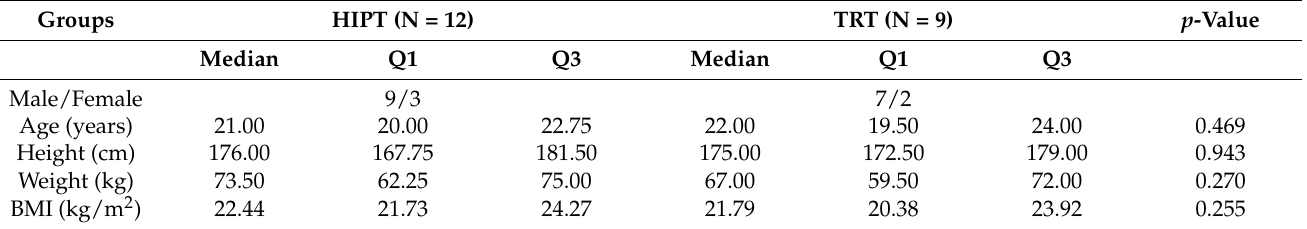
Table 1. Baseline characteristics of the HIPT and TRT groups.